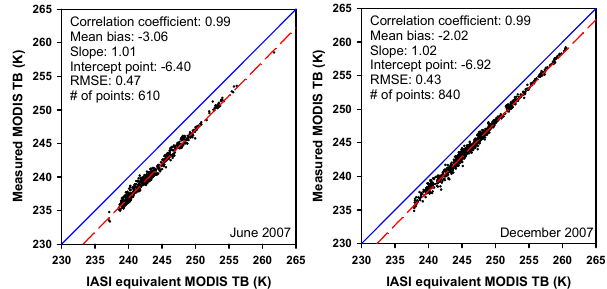
Figure 4: Scatter plots of IASI equivalent MODIS and measured MODIS brightness temperatures for June 2007 (left) and December 2007 (right). Fig. 4. Scatter plots of measured MODIS and IASI equivalent MODIS brightness temperatures for June 2007 (left) and Decem- ber 2007